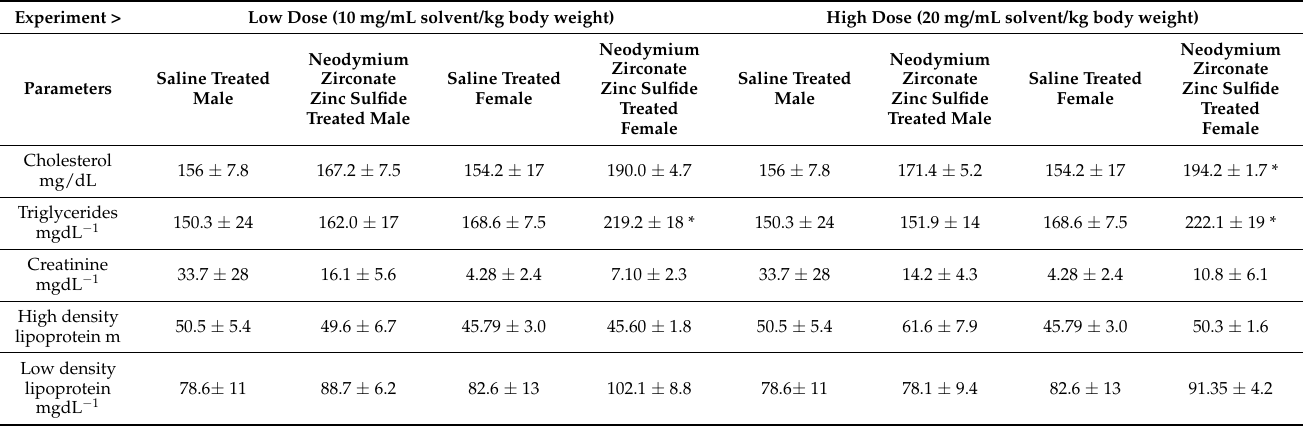
Table 2. Comparison of various studied parameters of serum biochemical analysis between mice with Neodymium zirconate zinc sulfide nanocomposite treated with low dose (10 mg/mL saline/kg body weight) and high dose (20 mg/mL saline /kg body weight) for 11 days with their respective untreated control groups. N = 8 for each treatment. Data are expressed as the mean ± standard error of the mean. p -values represent the results for two-sample t -test calculated for each studied